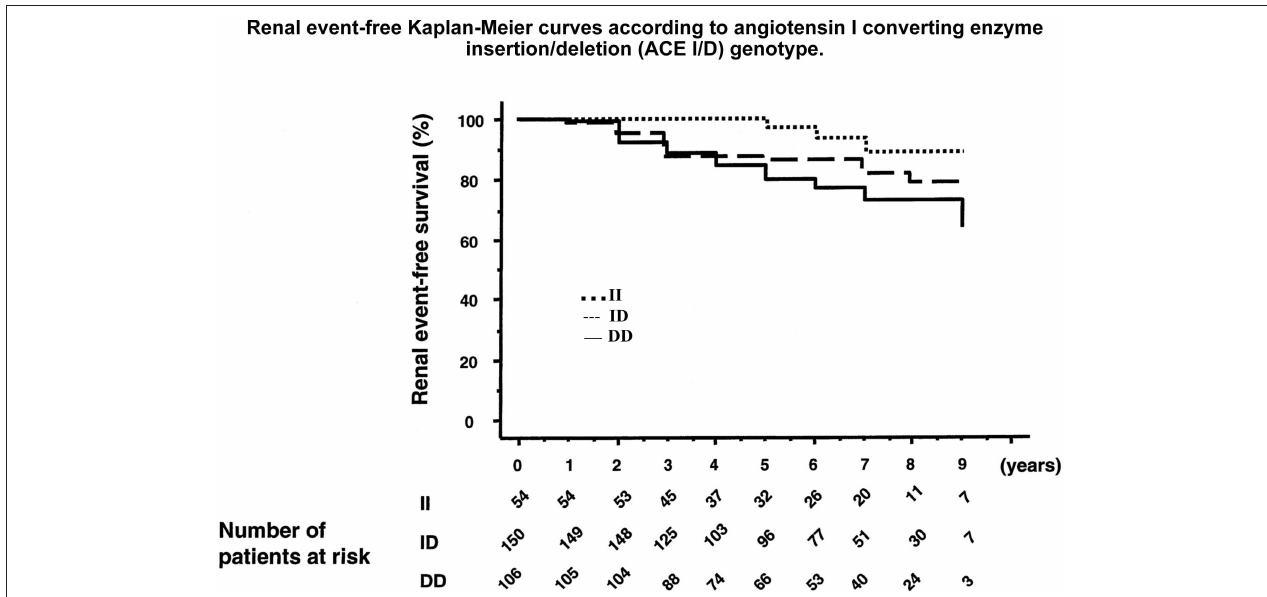
FIGURE 6 | Association of the ACE gene ID polymorphism with development of diabetic nephropathy in patients with type 1 diabetes. Graph shows cumulative incidence of renal events (progression from physiological to pathological microalbuminuria or from a given stage of nephropathy to a higher stage) according to ACE genotype. D allele is co-dominantly associated with higher ACE levels. Reproduced from Hadjadj et al. (97). This study documents the role of the genetic variation in ACE level in susceptibility to and progression of diabetic nephropathy. Same observation was made in other patient populations, before and after this study. See text and Marre et al. ( 93) through Hadjadj et al.